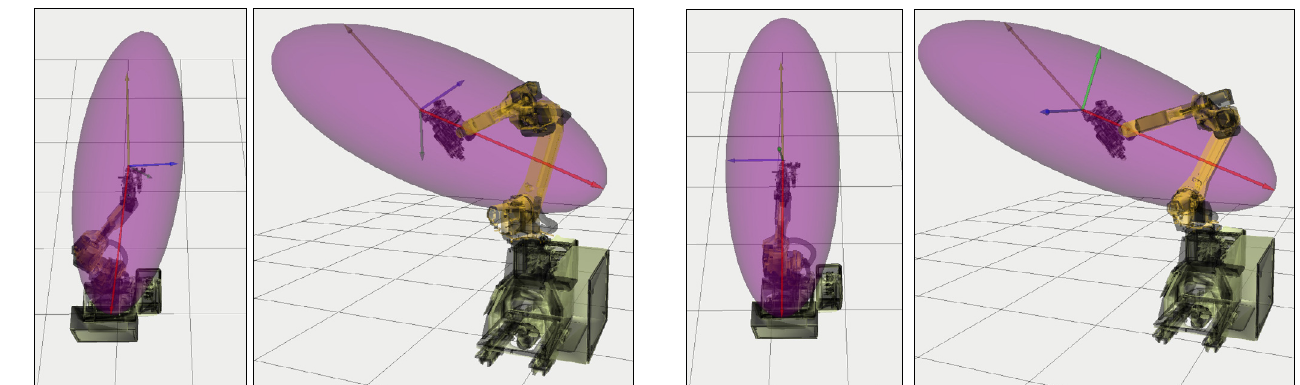
Fig. 6. Frontal and lateral view of the force ellipsoid of the last position of the 4th trajectory, planned with a trajectory duration of 0.55 s (left) and 1.4s (right).